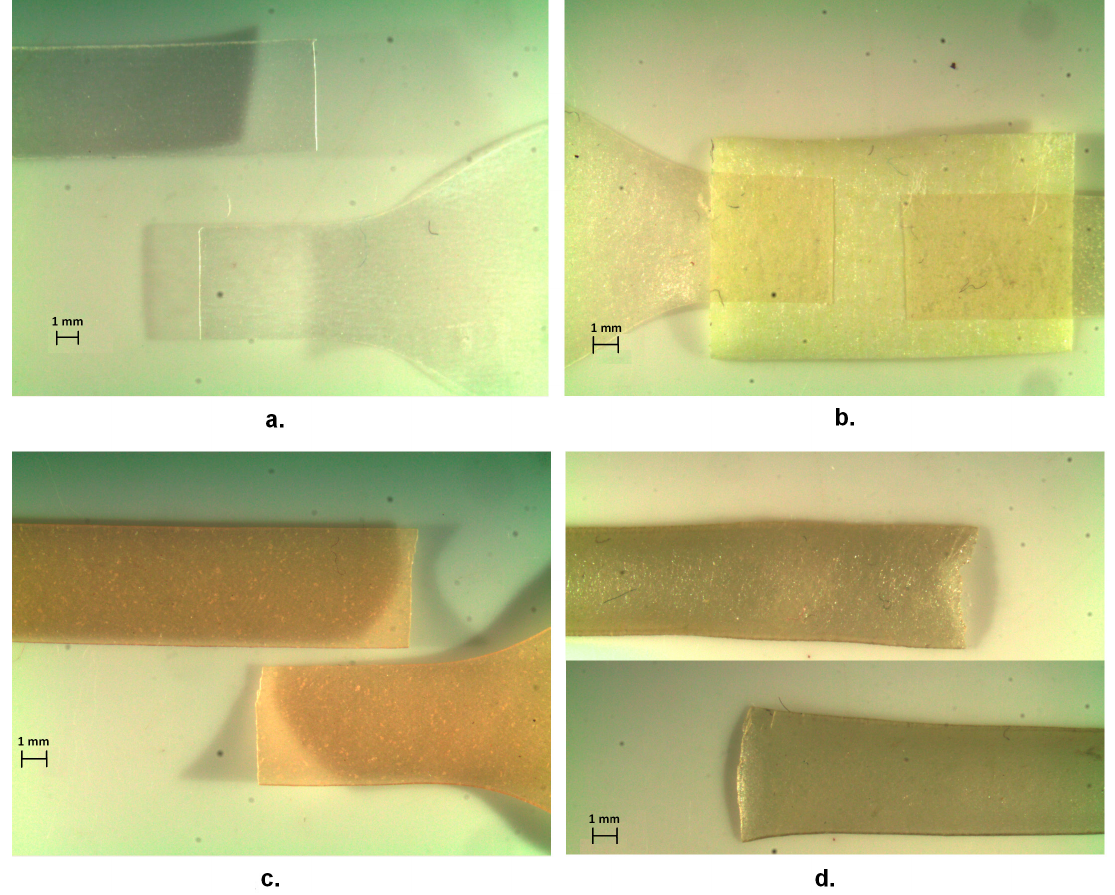
Figure 8. Tensile fractured samples of pure TPS (a.) and its blended films with nopal mucilage (type MA (b.), type MPM (c.) and type ME (d.))